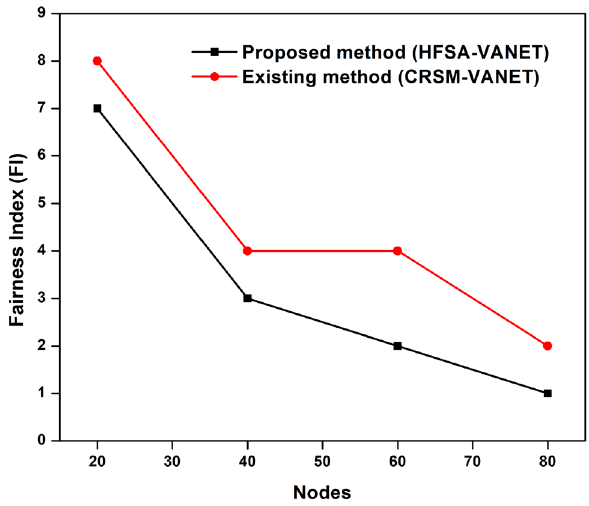
Figure 7. Fairness Index plot for the proposed and existing method.